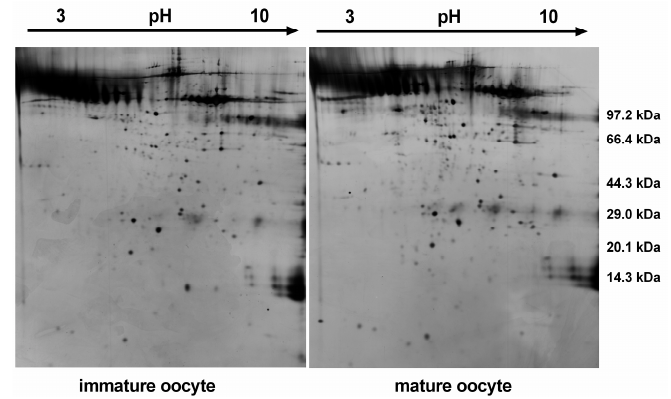
Figure 1. Images of silver nitrate-stained 2-DE gels from immature and mature oocytes. Proteins were separated on a pH 3–10 gradient using nonlinear (NL) immobilized pH Gradient (IPG) strips in the first dimension and 12.5% SDS–PAGE in the second dimension.